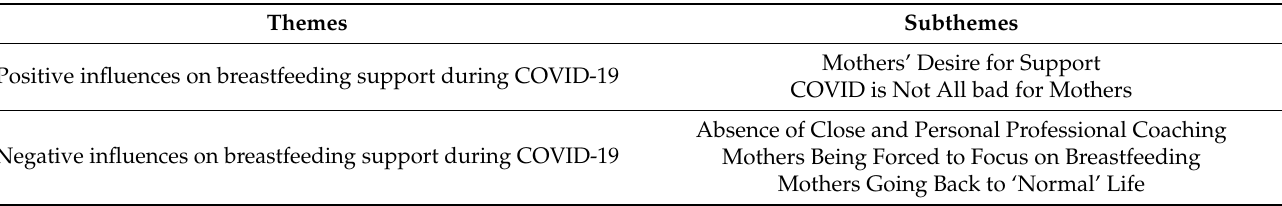
Table 3. Themes and subthemes of the